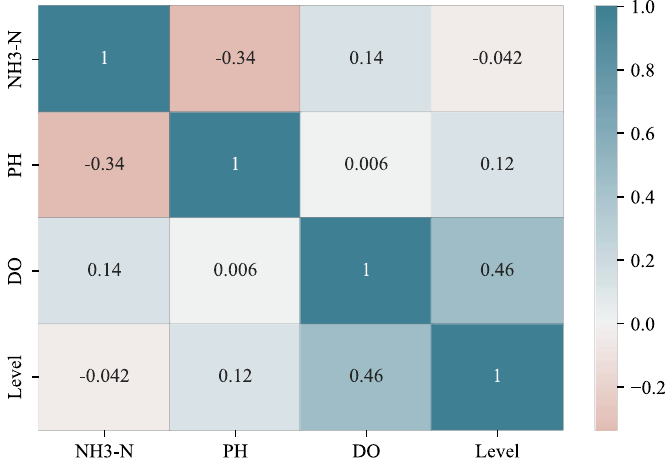
Figure 7. Correlation coefficient heat map.